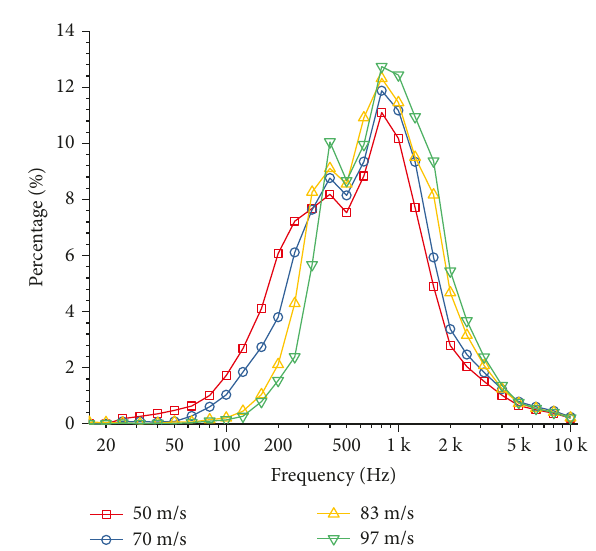
Figure 19: Sound source energy spectrum of the bottom of the head streamlined part (component 8), at di ff erent in fl ow